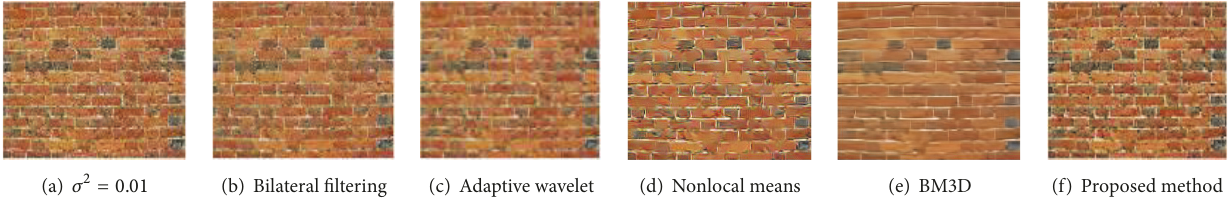
Figure 9: Image 9: comparison of various experimental results under noise variance 𝜎 2 = 0.01 .